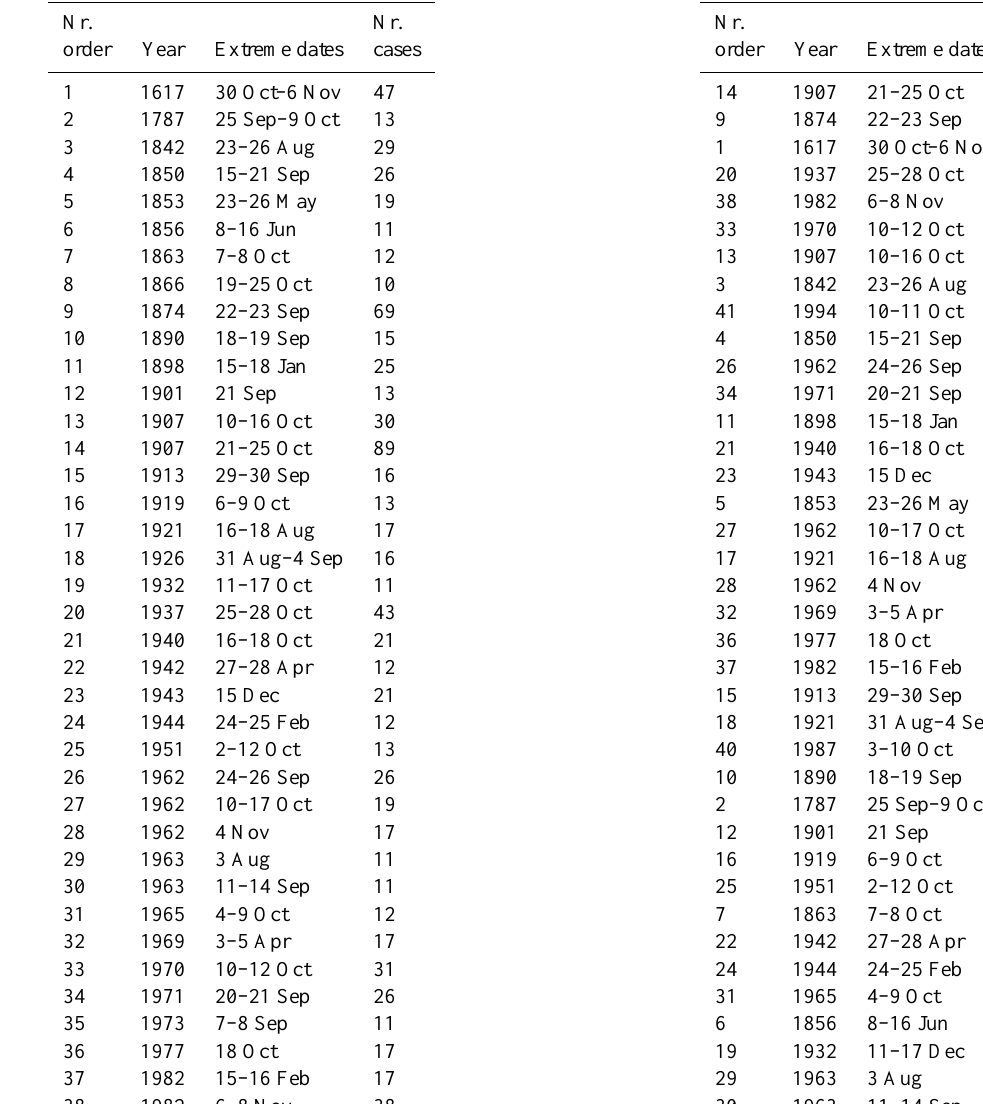
Table 2. Relation of flood events selected according to severity (10 or more cases per event). Chronologically sorted.